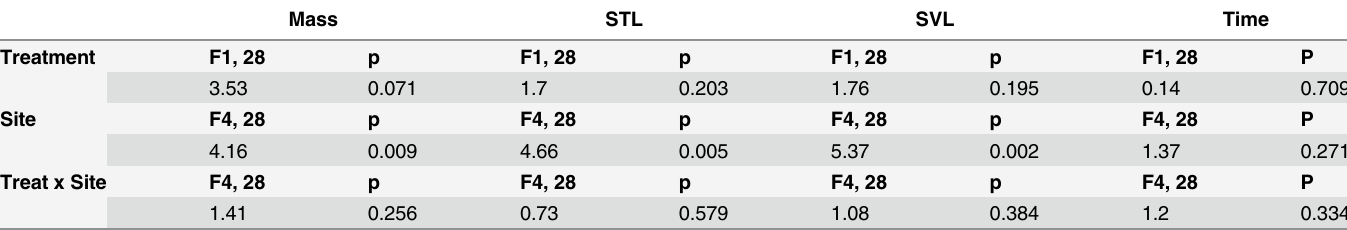
Table 1. ANOVA assessing the effect of treatment, site, and the interaction between site x treatment on larval weight, snout-tail length (STL), snout-vent length (SVL), and time to metamorphosis. Mass